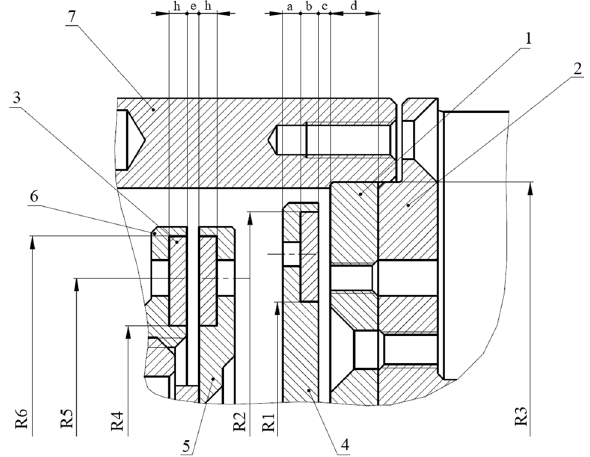
Fig. 2 Side cut of the